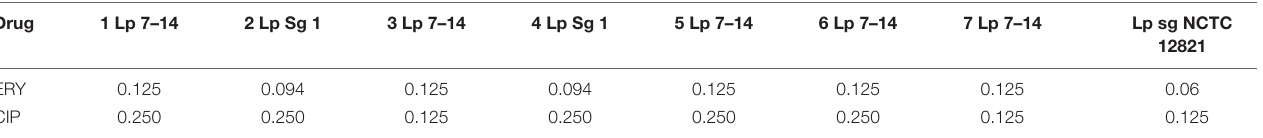
TABLE 2 | MIC values of ERY and CIP expressed as µ g/mL for L. pneumophila isolates for positive internal control.